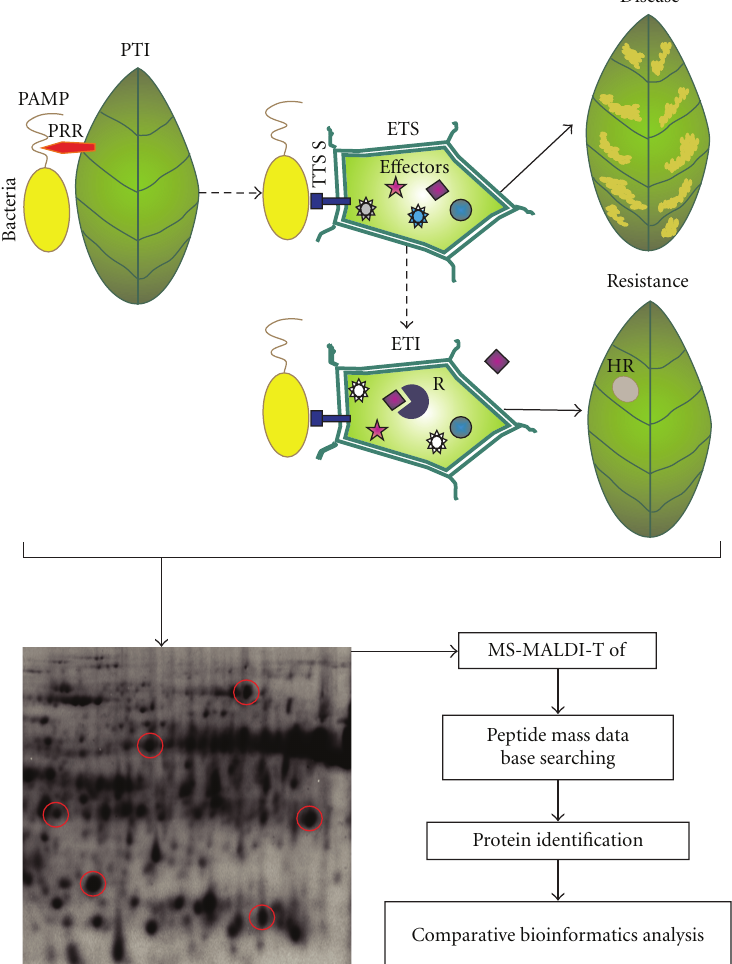
Figure 1: When the plant encounters a microorganism, the recognition of bacterial molecular patterns (PAMPs) by plant membrane receptors (PRRs) triggers the PAMP-triggered immunity (PTI). Pathogenic bacteria overcome this defense response by injecting the type three secretion system (TTSS) proteins called e ff ectors that promote pathogenicity. This process is called e ff ector-triggered susceptibility (ETS) and leads to plant disease. Some plants respond to these e ff ectors through the development of R proteins that recognize e ff ectors and activate the so-called e ff ector-triggered immunity (ETI). This is a response associated with a specific programmed cell death called hypersensitive response (HR) that limits pathogen growth and culminates into plant resistance. Protein samples are extracted from tissues of di ff erent plant cultivars inoculated with di ff erent bacterial strains or bacterial components that trigger the above-mentioned responses. Spots showing di ff erential abundance compared to control treatment (circled in red in the gel picture) are then subjected to subsequent proteomic analysis to resolve response-specific plant protein